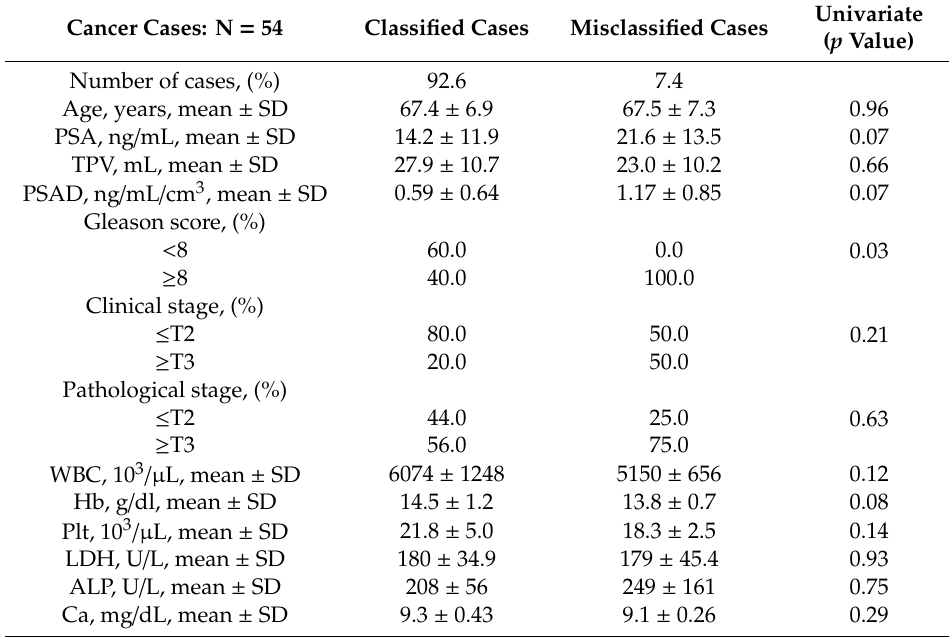
Table 2. Univariate analysis of clinicopathological features: deep learning classified cancer cases versus misclassified cancer cases. PSA = Prostate-specific antigen, TPV = Total prostate volume, PSAD = PSA density, WBC = White blood cell, Hb = Hemoglobin, Plt = Platelet, LDH = Lactate dehydrogenase, ALP = Alkaline phosphatase, Ca = Calcium, SD = Standard